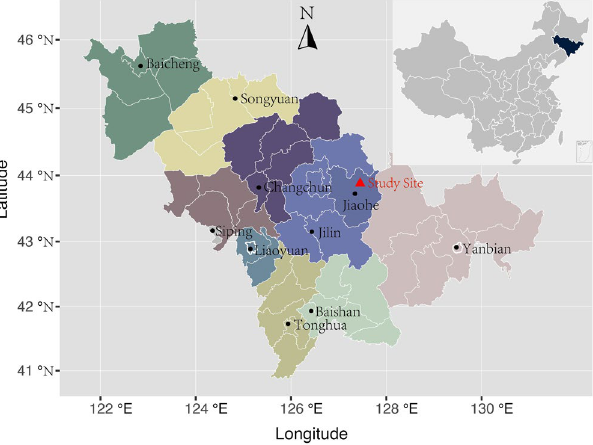
Figure 6. The study sites. The four plots are located in Dongdapo Nature Reserve, Jiaohe, Jilin Province, North- eastern China. The map was produced using the ggplot2 54 and maptools 55 packages in R